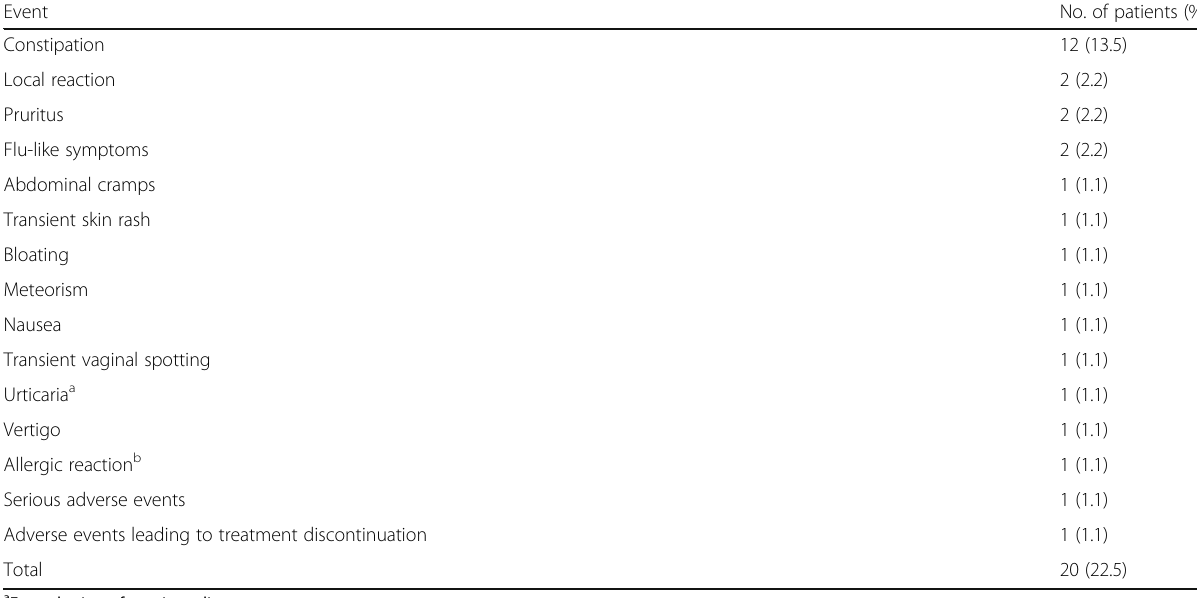
Table 4 Adverse events in the study patients ( n = 89)